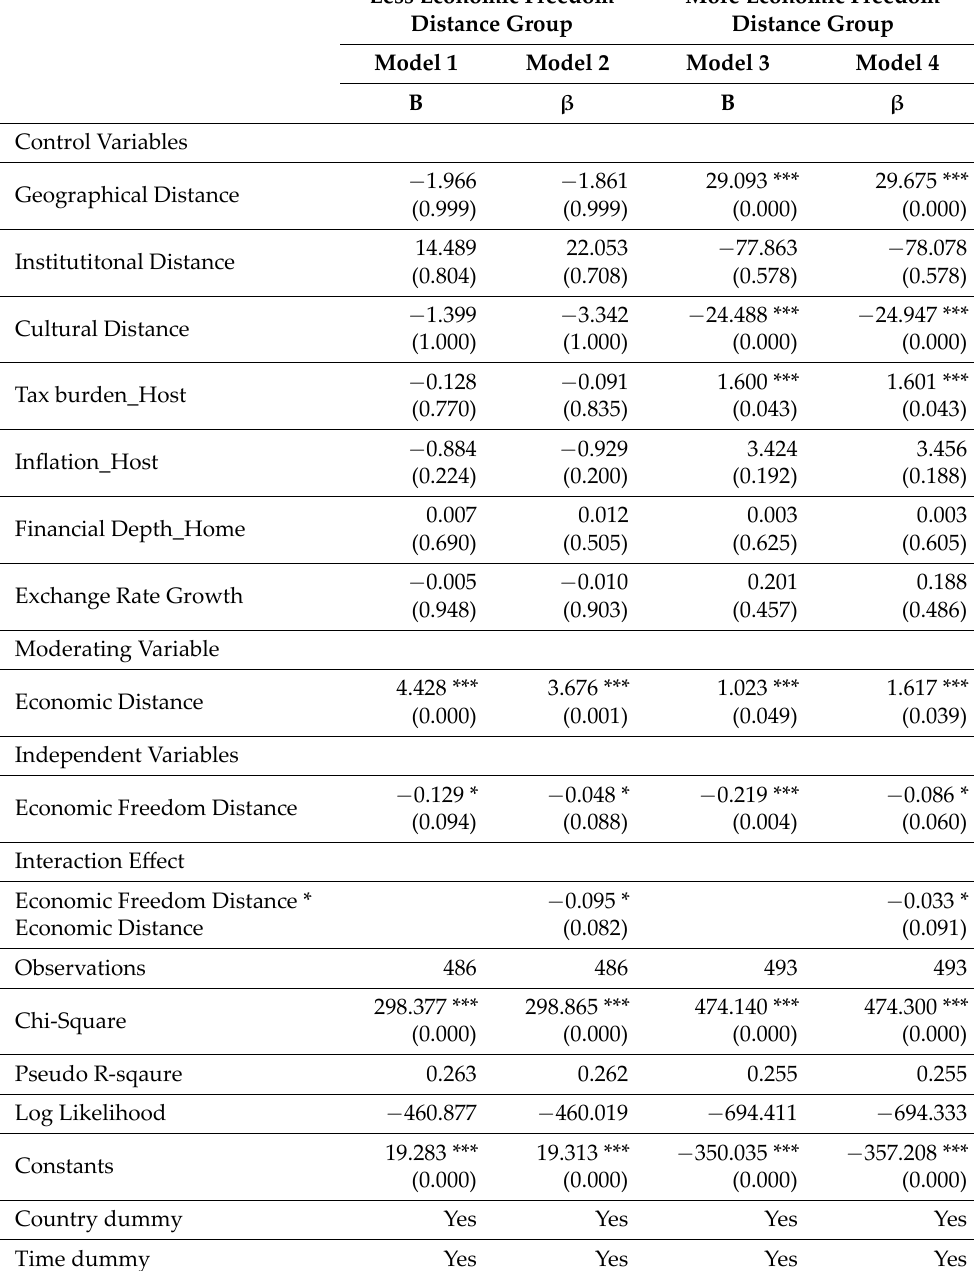
Table 6. Tobit regression model results presenting the impact of independent variables on India’s in‑ bound CBA volume and the control variables for less economic freedom distance and more economic freedom distance groups of